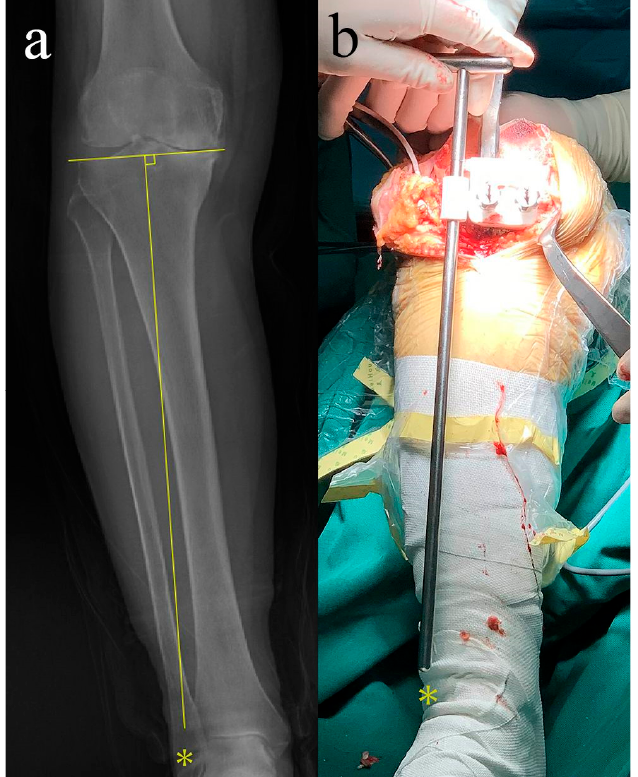
Figure 6. Intraoperative verification of the accuracy of the tibial PSI on the coronal plane. The yellow stars represent the orientation of the vertical line of the tibial articular surface. ( a ) Determining the orientation of the vertical line of the tibial articular surface in preoperative X-ray. ( b ) Conforming the orientation of the vertical line of the tibial cutting surface during the surgery.